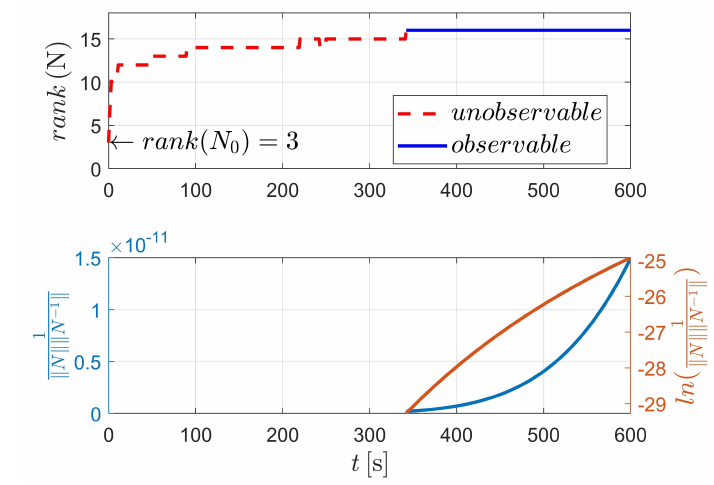
Figure 13. Observability simulation of case IV